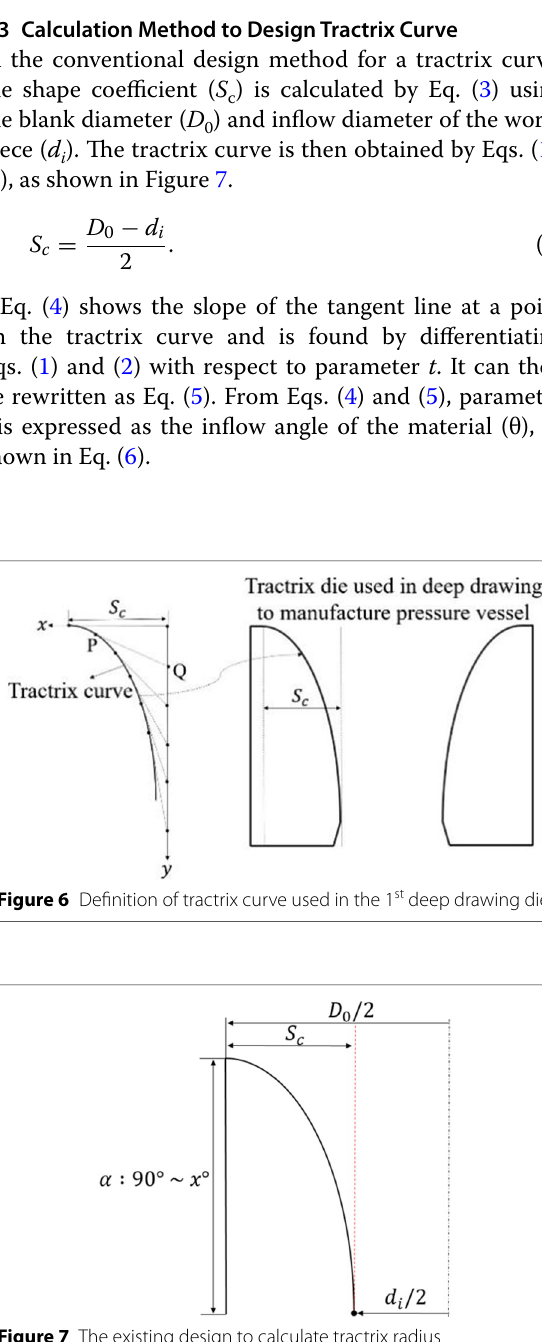
Figure 6. A tractrix curve is defined by parameter t and